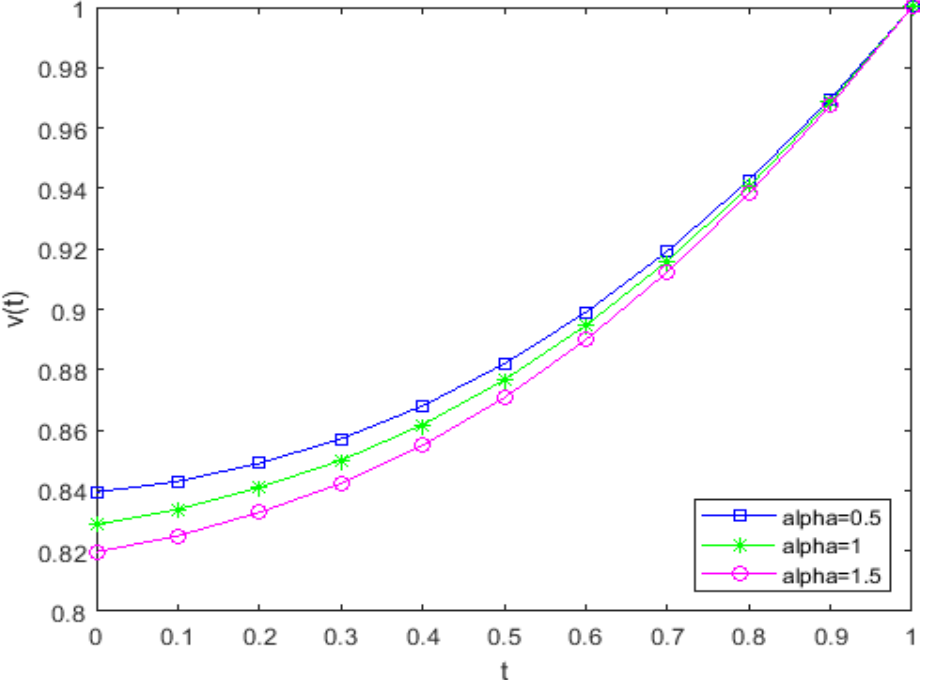
Figure 1. Behaviour of the concentration at different values of the parameter.